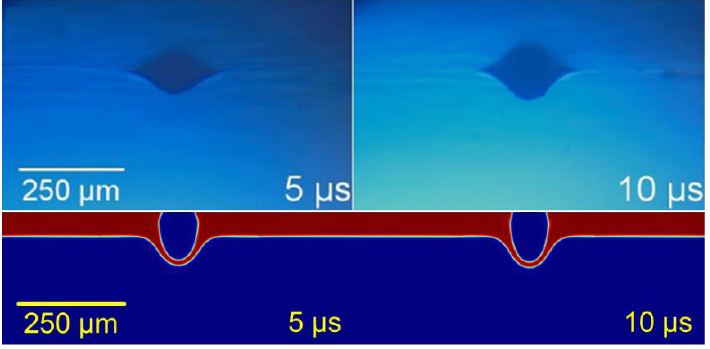
Figure 7. Non-transference regime. Upper row adapted from [13], with PV17F paste. Lower row: simulation at 300 MPa at its maximum, for 60 μm of 2 Pa·s paste .